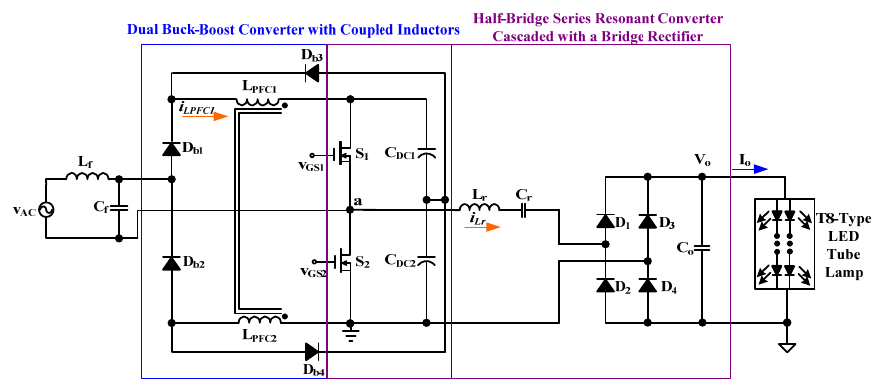
Figure 2. The presented single ‐ stage driver for supplying a T8 ‐ type LED tube lamp.